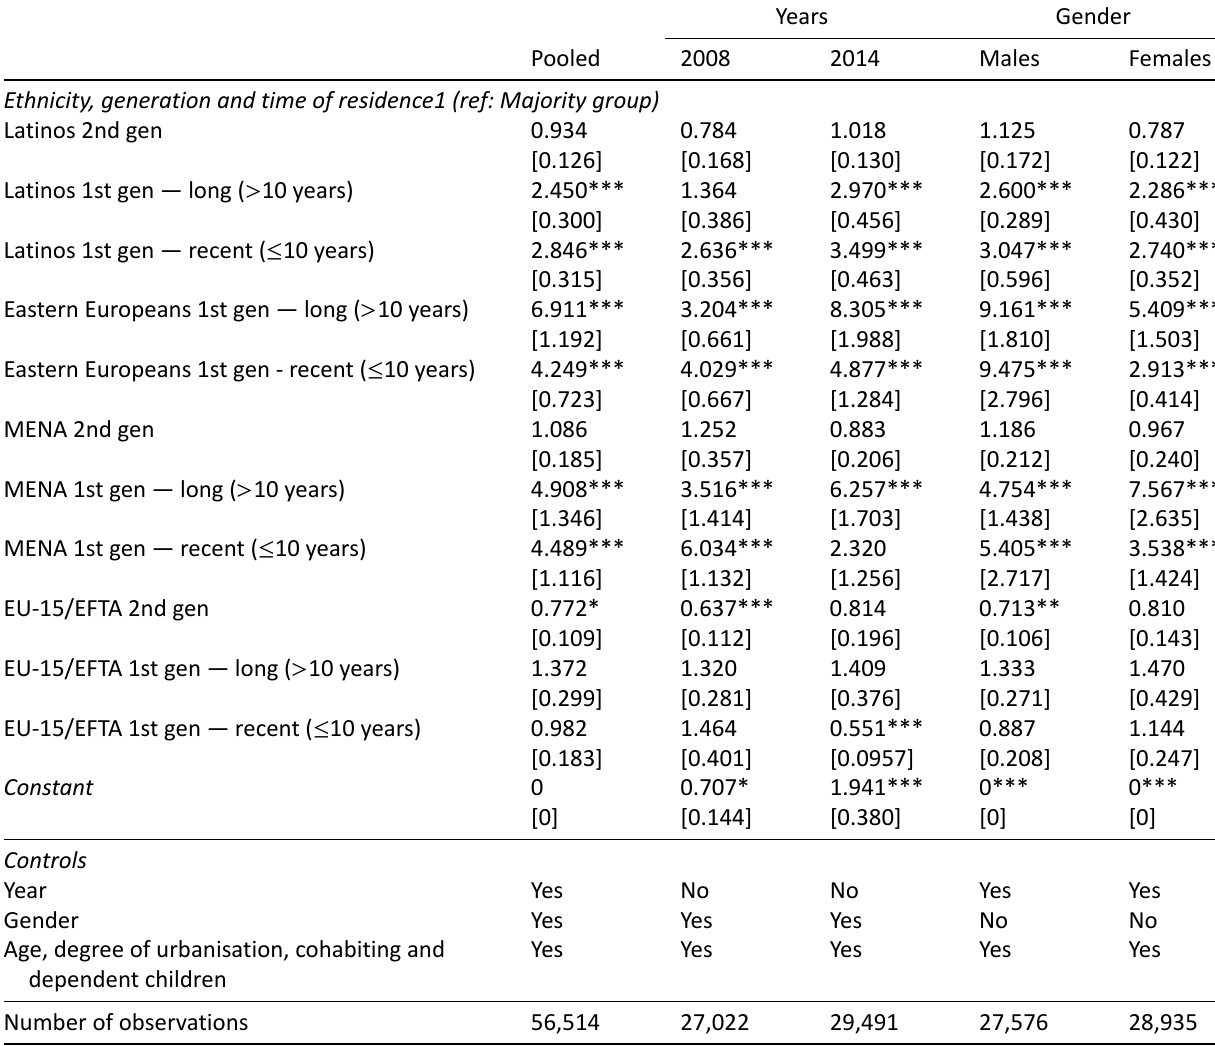
Table A1. Determinants of over-education of immigrants in Spain. Odds